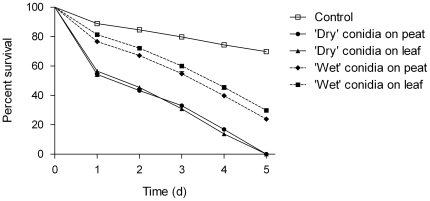
Effects of substrate and formulation.Mean (± SEM) cumulative proportional survival of adult Culiocides nubeculosus exposed for 6 days to ‘dry’ and ‘wet’ conidia of Metarhizium anisopliae V275 in cages within a greenhouse. Treatments consisted of ‘dry’ or ‘wet’ conidia at dose of 2.5×109 conidia m−2 dusted or applied on peat and leaf litter. Corresponding control groups were exposed to the solvent only. Data represent survival of six replicates of approximately 200 adult males and females/replicate.